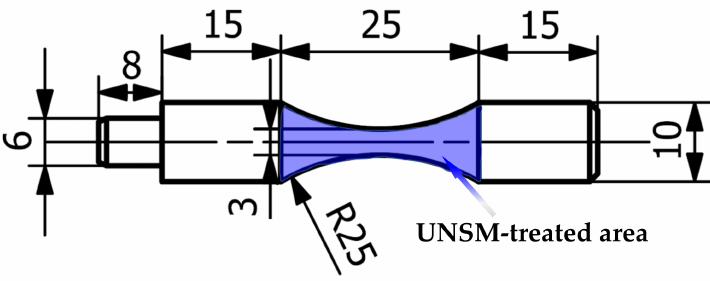
Figure 3. Schematic view of UFT sample.